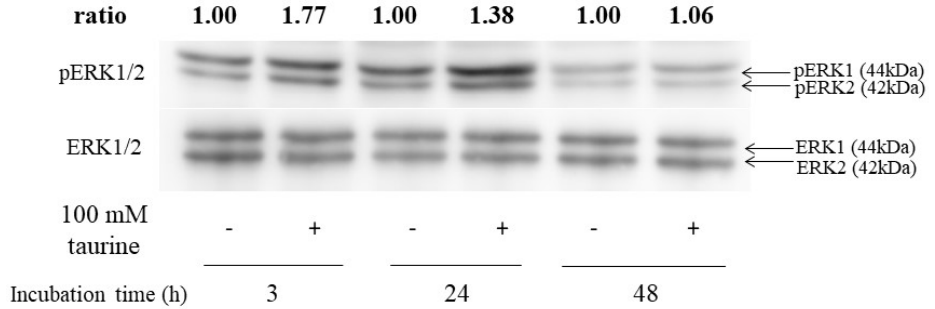
Figure 10. Effect of taurine on the phosphorylation (activation) of ERK1/2. Caco-2 cells were cultured in medium containing 100 mM of taurine for 3, 24, and 48 h. The cell lysate was recovered and used for the western blot analysis. The bands were quantified using an image gauge. Changes in expression are presented as relative values, with the expression level in the control at each treatment time as 1.